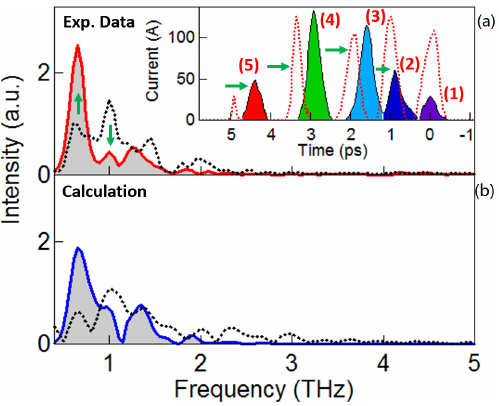
Figure 7. Narrowband generation from a ramped comb beam: ( a ) Measured THz spectrum (red line), compared to that generated from uniform beam (black dotted line); ( b ) Calculated THz spectrum from measured current distributions report in the inset: ramped (blue curve) and uniform (black dotted curve). Inset: measured ramped current distribution compared to the uniform one (red dotted line) previously